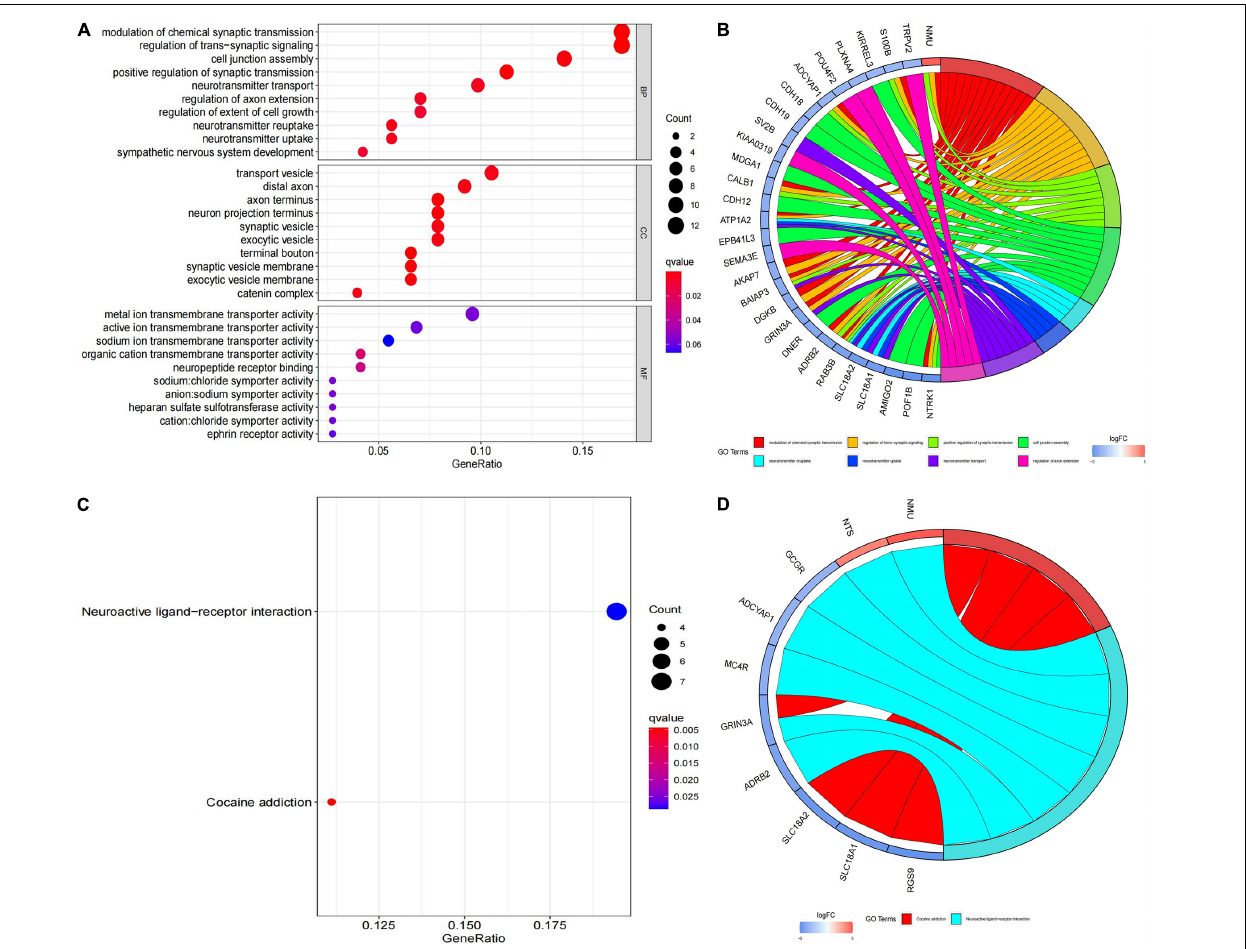
FIGURE 2 | Kyoto Encyclopedia of Genes and Genomes (KEGG) pathway analysis and Gene Ontology (GO) functional enrichment analysis. (A) Biological process, cellular component and molecular function annotation diagram of differentially expressed genes (DEGs); (B) ring plot showing GO enrichment. The left side indicates the DEGs, the red gene band indicates upregulation, and blue indicates downregulation. The band on the right with different colors represents different GO terms. The connecting line indicates that the gene is included in the GO term; (C) KEGG annotation diagram of the DEGs; (D) ring plot showing KEGG enrichment. The left side indicates the DEGs, the red gene band indicates upregulation, and blue indicates downregulation. The band on the right with different colors represents different KEGG terms. The connecting line indicates that the gene is included in the KEGG